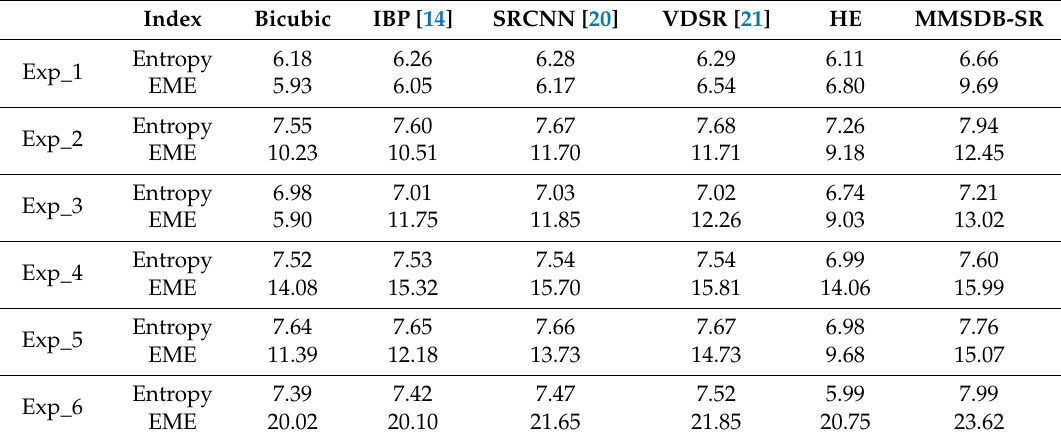
Table 6. Objective evaluation indexes of different reconstruction methods in real experiments.